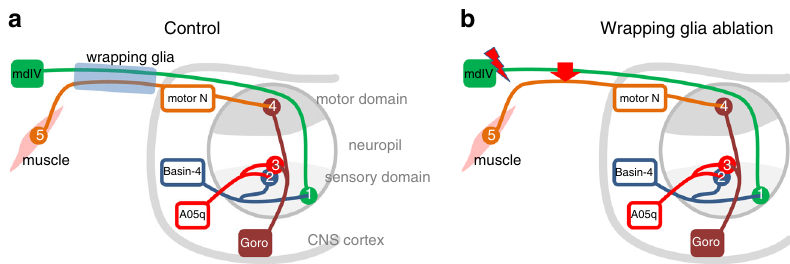
Fig. 9 Schematic representation of the Goro circuit. a Control situation. The rolling response is triggered when a noxious signal is perceived by the mdIV neurons and transmitted via the abdominal nerves to the ventral nerve cord. Here, the mdIV neuron synapses onto the Basin-4 neurons (1) which project to the A05q neurons (2) which innervate the Goro neurons (3) that act as the command neurons orchestrating the activity of motor neurons (4). Additional pathways exist which involve neurons located in the brain hemispheres. b Upon ablation of wrapping glial cells, mdIV neuron activation results in ephaptic crosstalk and uncontrolled activation of motor axons. Likewise, upon ablation of wrapping glial cells, Goro neuron activation results in ephaptic crosstalk ( fl ash) and activation of a sensory input affecting the rolling per second. Thereby we were able to obtain a 10 msec time